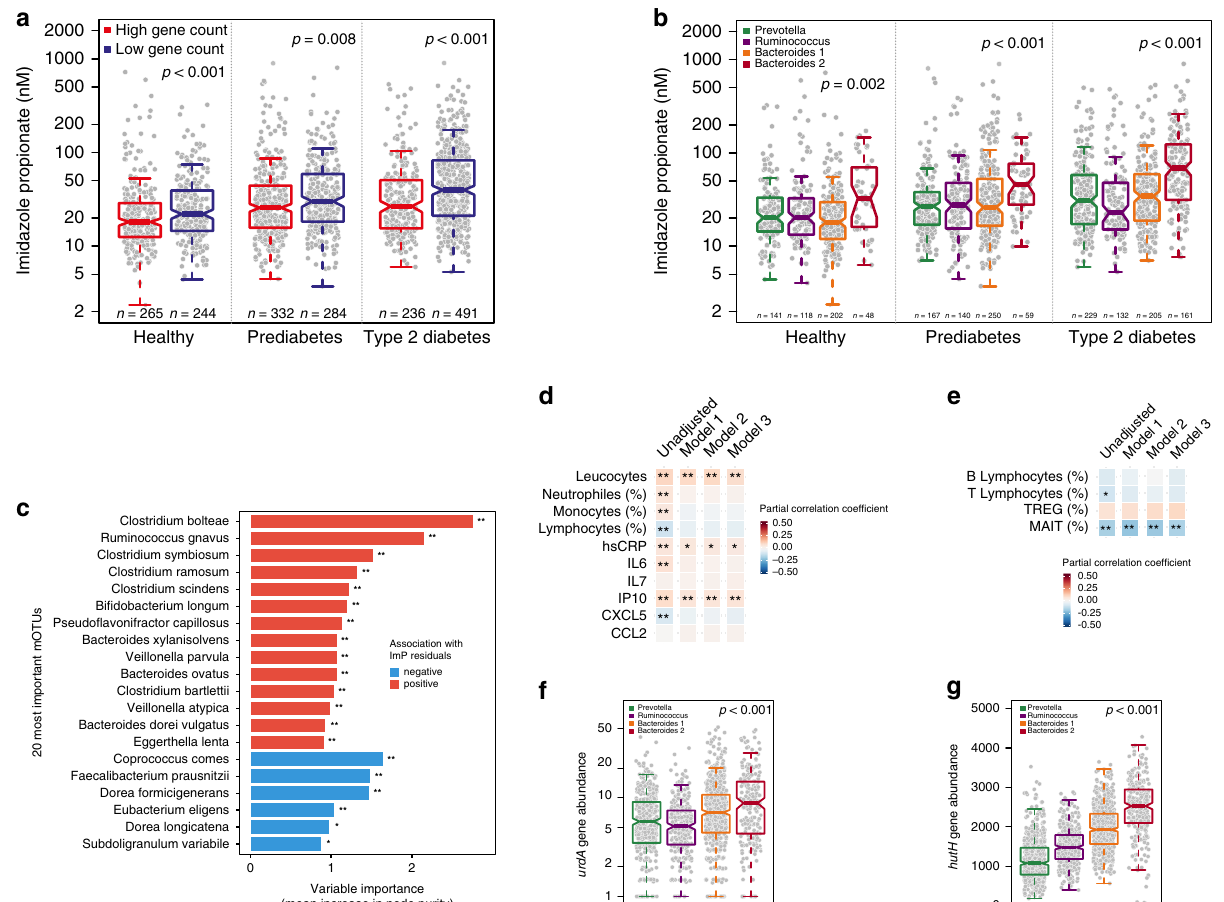
Fig. 2 Imidazole propionate is associated with a pro-in fl ammatory microbiota. Serum levels of imidazole propionate (ImP) in healthy subjects ( n = 509), subjects with prediabetes ( n = 616), and with type 2 diabetes ( n = 727) according to a bacterial gene count and b enterotypes. P- values were calculated with linear regression adjusted for age, gender, BMI, ethnicity, and creatinine clearance. c Random forest for the 20 most signi fi cant mOTUs correlated with ImP residuals, after adjustment for age, gender, BMI, ethnicity, creatinine clearance, and diabetes status. FDR adjusted P -value of spearman correlation between taxa and imp residuals * P < 0.05, ** P < 0.01. See also Supplementary Table 4. d Partial correlation matrix for ImP serum levels and serum leucocytes count (10 9 /l), neutrophils (%), monocytes (%), lymphocytes (%), C-reactive protein (CRP), Interleukin 6 (IL-6), Interleukin 7 (IL-7), Interferon gamma-induced protein 10 (IP-10), C-X-C motif chemokine 5 (CXCL5), chemokine (C-C motif) ligand 2 (CCL2). Pearson partial correlation coef fi cients and P -values were calculated using partial correlations adjusted for Model 1: age, gender, body mass index, and ethnicity. Model 2: Model 1 plus creatinine clearance, Model 3: Model 2 plus diabetes status. * P < 0.05, ** P < 0.01, *** P < 0.001. See also Supplementary Table 5. e Partial correlation matrix in a subgroup of patients ( n = 439) between serum ImP and circulating B- and T lymphocytes (%), regulatory T cells (TREG, %) and mucosal-associated invariant T cell (MAIT, %). Partial correlation coef fi cients (Pearson for all variables except for MAIT cells for which Spearman coef fi cient was used since variable distribution remained skewed despite log-transformation) and P -values were calculated using partial correlations for Model 1: age, gender, body mass index, and ethnicity. Model 2: Model 1 plus creatinine clearance, Model 3: Model 2 plus diabetes status. * P < 0.05, **False discovery rate (FDR) adjusted P < 0.05. See also Supplementary Table 6. Relative abundances of urdA gene ( f ) and hutH ( g ) according to enterotype. P- values were calculated with linear regression adjusted for age, gender, BMI, and ethnicity. For a , b , f , g data are represented as boxplots: middle line is the median, the lower and upper hinges are the fi rst and third quartiles, the upper whisker extends from the hinge to the largest value no further than 1.5× the interquartile range (IQR) from the hinge and the lower whisker extends from the hinge to the smallest value at most 1.5× IQR of the hinge. Gray dots are single data points. Source data are provided as a Source Data fi